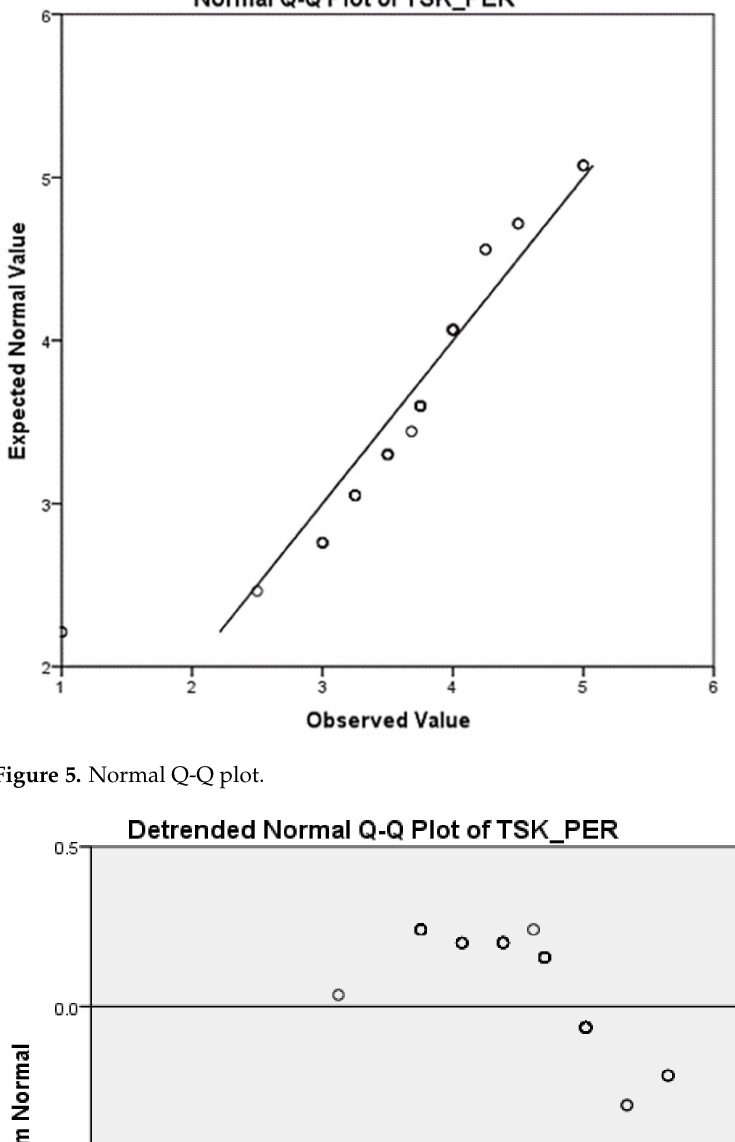
Figure 5. Normal Q-Q plot.